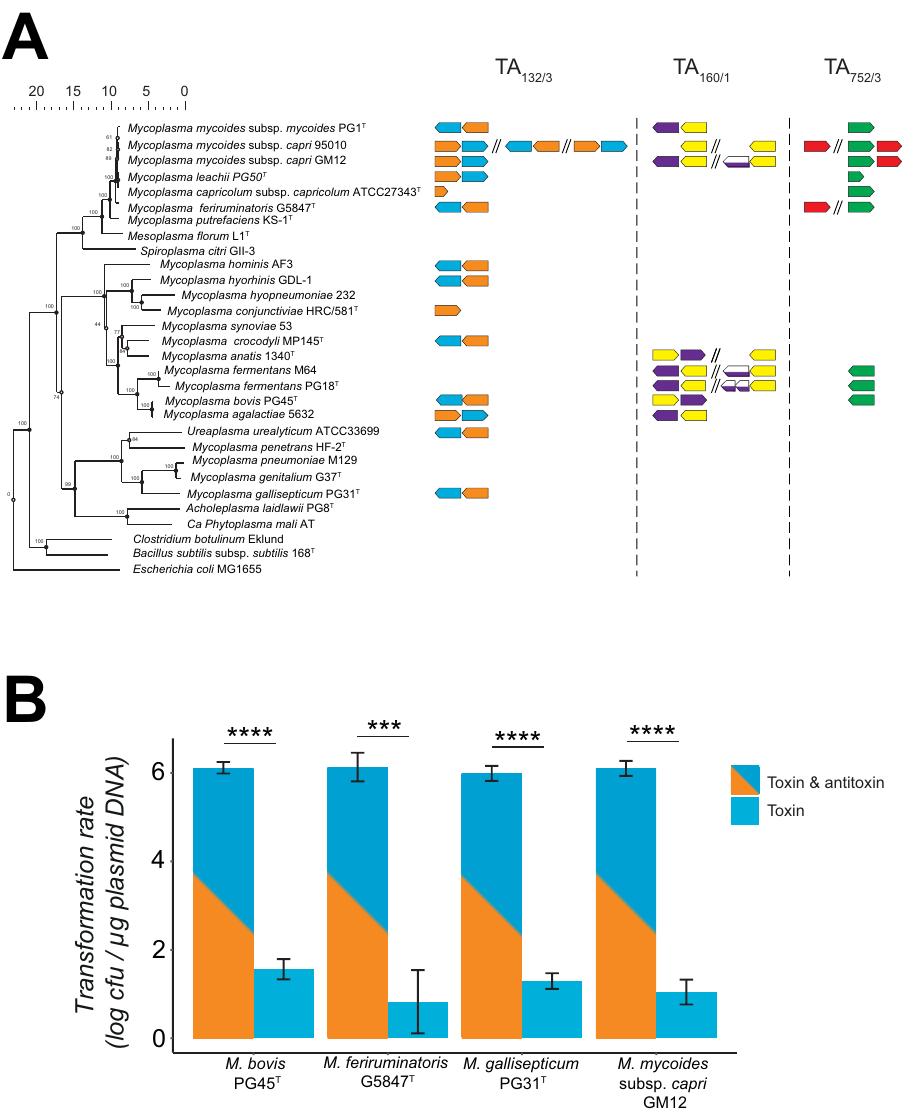
Fig 6. Detection of homologues of the three investigated TA systems in selected mycoplasmas and the functional analysis of homologues of the TA 132/3 in M . bovis , M . feriruminatoris , and M . gallisepticum . (A) A tree highlighting the phylogenetic relationship of the different species based on 16SrRNA gene sequences is displayed (left). The outgroup species Clostridium botulinum , Bacillus subtilis and Escherichia coli were included. Tree was constructed using Bionumerics 8.0. Bootstrap values indicated at the nodes were calculated using 500 simulations. Identification of the Mmc TA system homologs (right) was done using Molligen 4.0. (B) M . capricolum subsp. capricolum ATCC 27343 T was transformed with different plasmid constructs based on pMYCO1 harboring the T 133 and TA 132/3 homologues of M . bovis , M . feriruminatoris and M . gallisepticum under the control of the natural promotor of M . mycoides subsp. capri . Control plasmids were pMYCO1 plasmid harboring T 133 and TA 132/3 from M . mycoides subsp . capri . Graphs represents the mean of three independent biological replicates and bars indicate standard deviations. Significance is indicated ( ��� p � 0.001, ���� p �